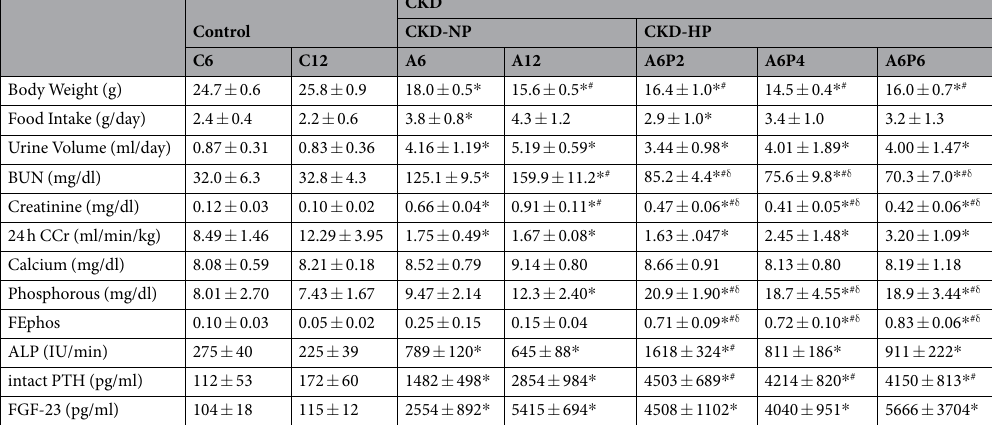
Table 1. Serum, urine biochemistries and physiological parameters in CKD and control mice. BUN, blood urea nitrogen; 24 h CCr, 24 hour creatinine clearance; FEphos, fractional excretion of phosphorus; ALP, alkaline phosphatase; PTH, parathyroid hormone; FGF-23, fibroblast growth factor 23. The data are represented as the means ± SEM (n = 5). * P < 0.05, ** P < 0.01 vs C6 and C12 by non-repeated measures ANOVA. # P < 0.01, ## P < 0.01 vs A6 by non-repeated measures ANOVA. δ P < 0.05, δδ P < 0.01 vs A12 by non-repeated measures